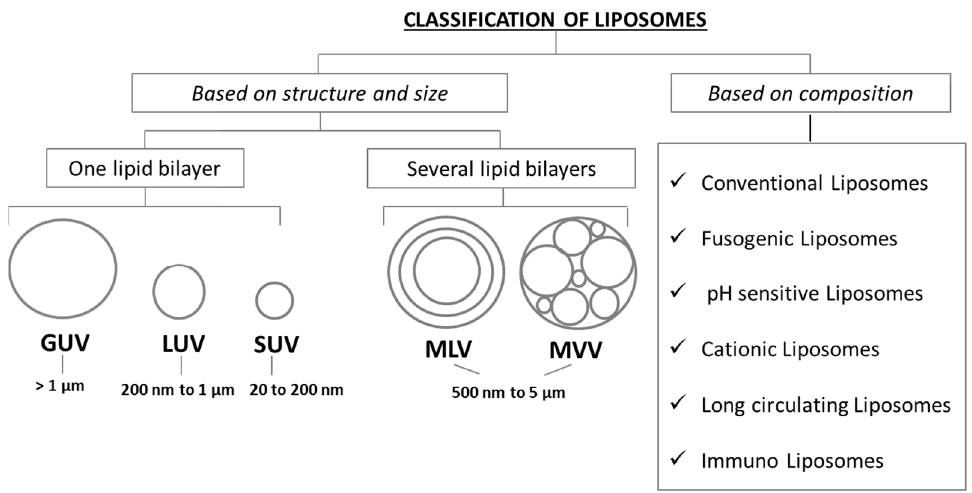
Figure 2. Liposomes classification by structure/size and lipid composition.